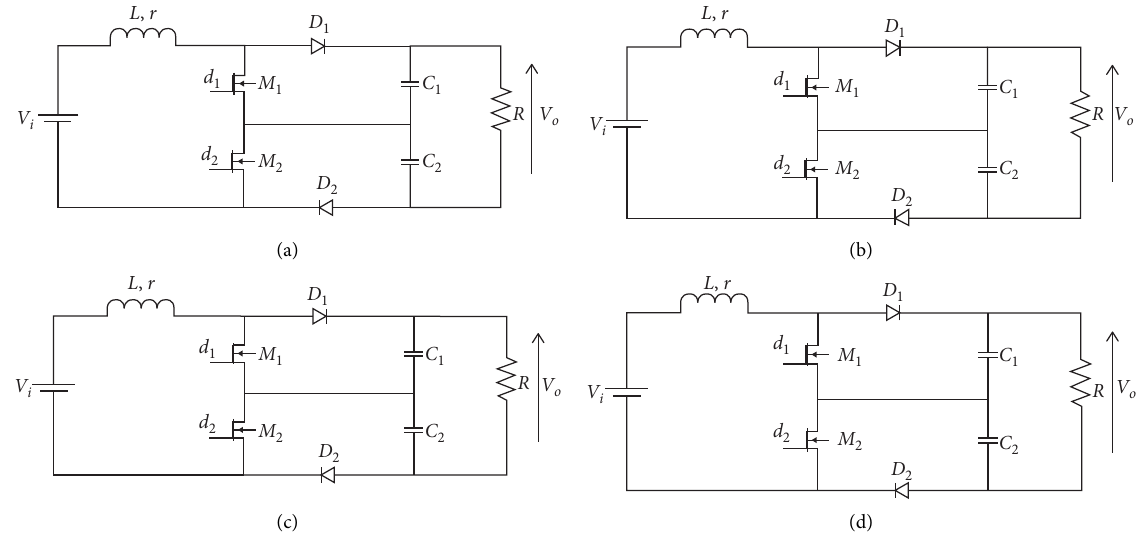
1 , M 2 on; D 1 , D 2 off, (b) M 1 , D 2 on; D 1 , M 2 off, (c) D 1 , M 2 on; M 1 , D 2 off, and (d) D 1 , D 2 on;